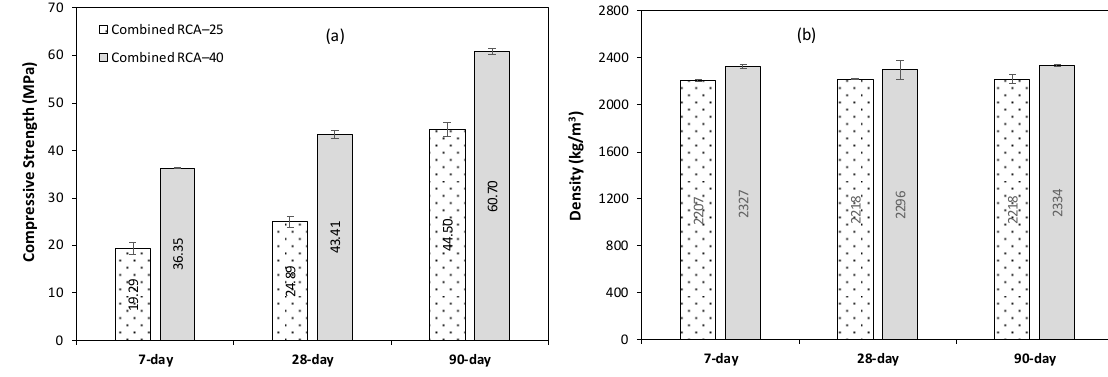
Figure 2. ( a ) Compressive strength and ( b ) density development of combined RCA concrete.